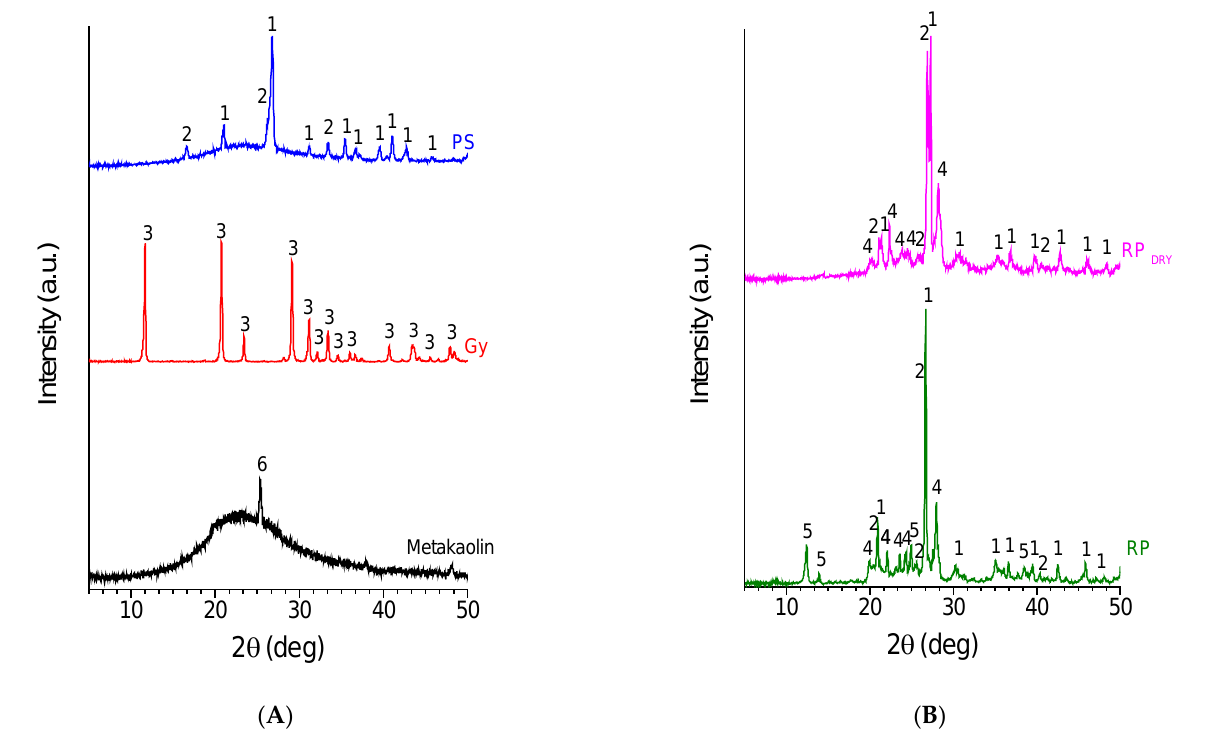
Figure 1. X-ray diffraction pattern of raw materials. Part ( A ): porcelain stoneware (PS), gypsum (Gy), and metakaolin; Part ( B ): Raw pressed (RP) and annealed raw pressed (RP dry ) waste. The numbers correspond to main diffraction peaks (with relative ICDD PDF-4+ 2021 card numbers) of 1-Quartz (SiO 2 ) (01-083-0539); 2-Sillimanite (Al 2 SiO 5 ) (01-088-0893); 3-Gypsum (CaSO 4 · 2(H 2 O)) (00-003-0053); 4-Albite (NaAlSi 3 O 8 ) (01-089-6427); 5-Kaolinite (Al 2 Si 2 O 5 (OH) 4 ) (01-080-0886); and 6-Anatase (TiO 2 ) (01-070-7348).